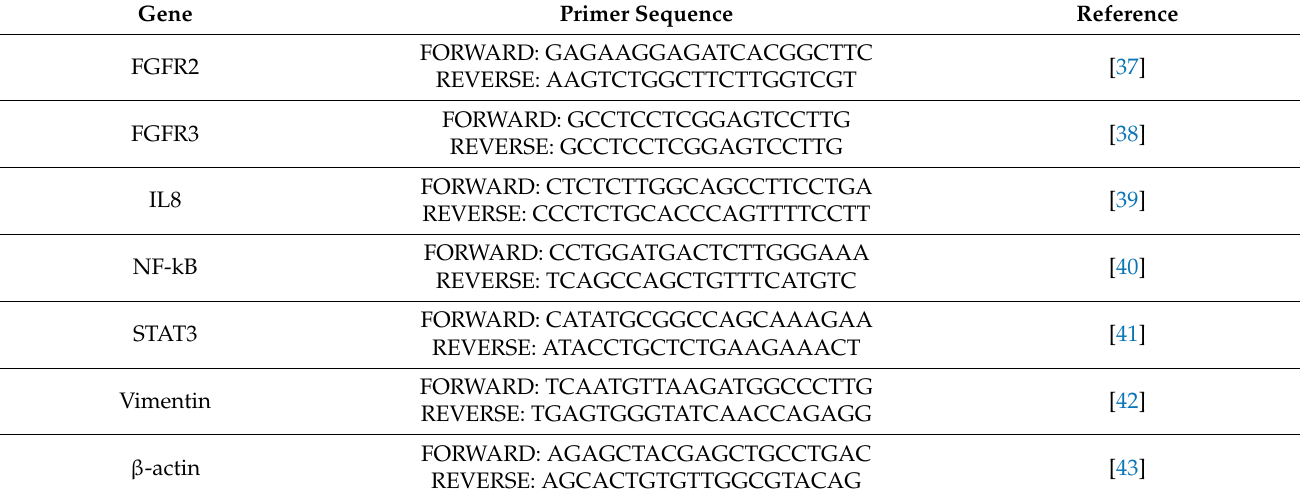
Table 4. Primer sequences for RT-qPCR of target